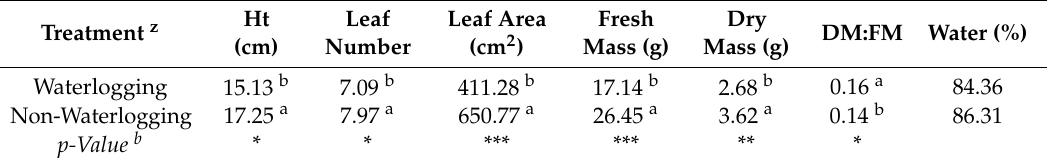
Table 1. The e ff ects of a 10-day waterlogging or non-waterlogging treatment on cucumber plants in an early developmental stage. Plants were harvested at the end of 10